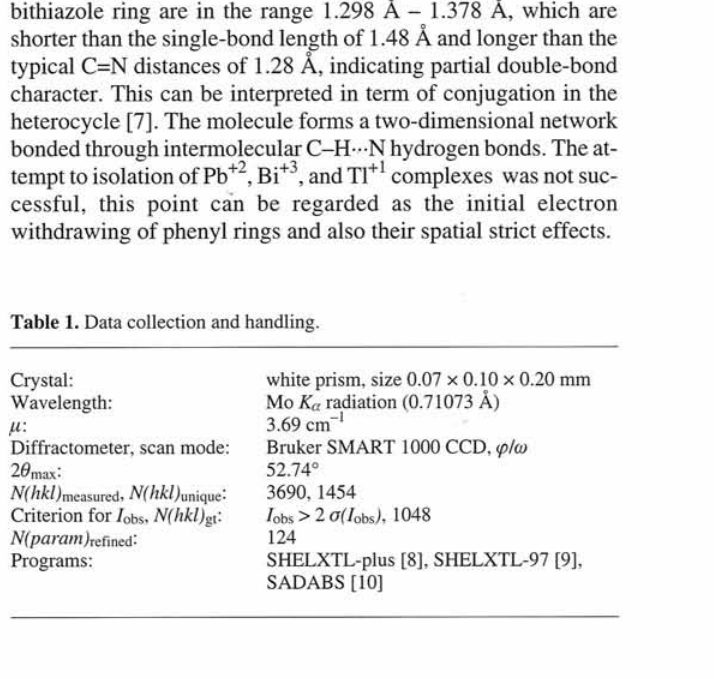
Table 2. Atomic coordinates and displacement parameters (in Â ?